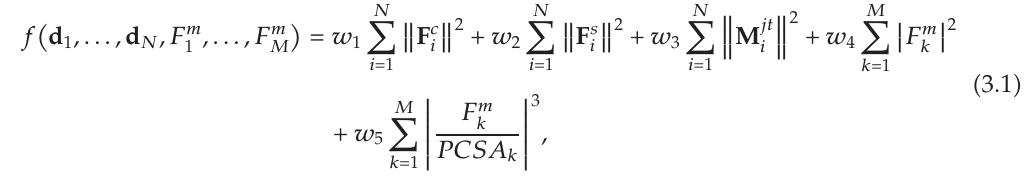
c i and the shear force F